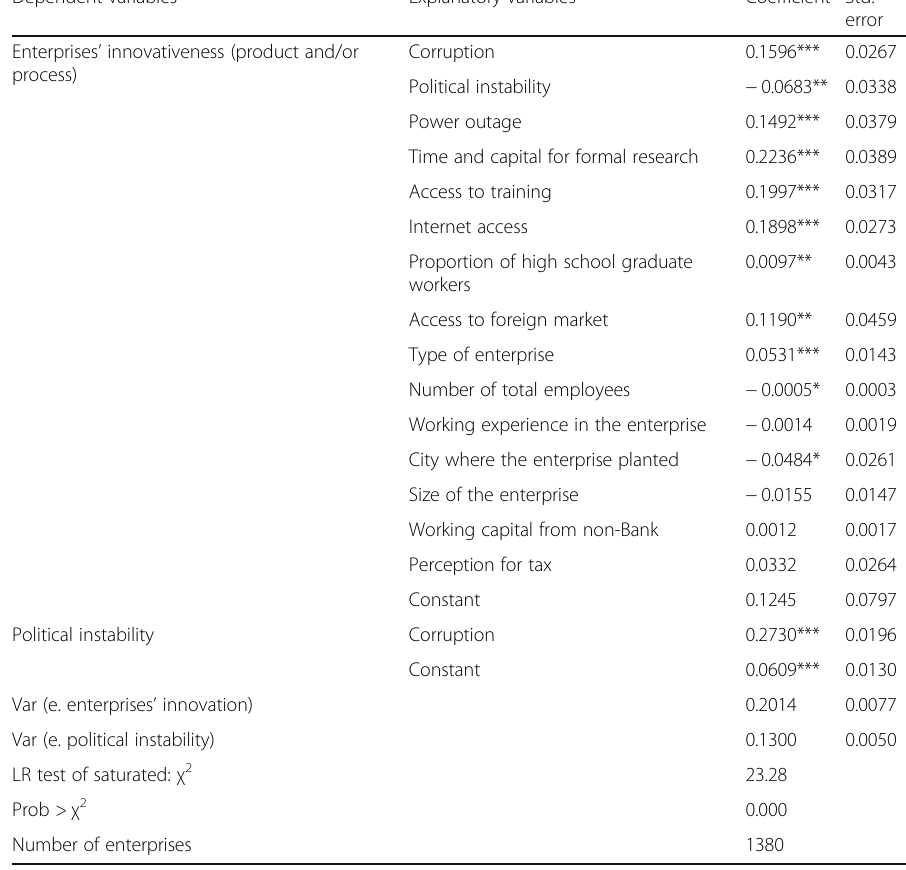
Table 8 SEM regression result (dependent variable enterprises ’ innovativeness) Dependent